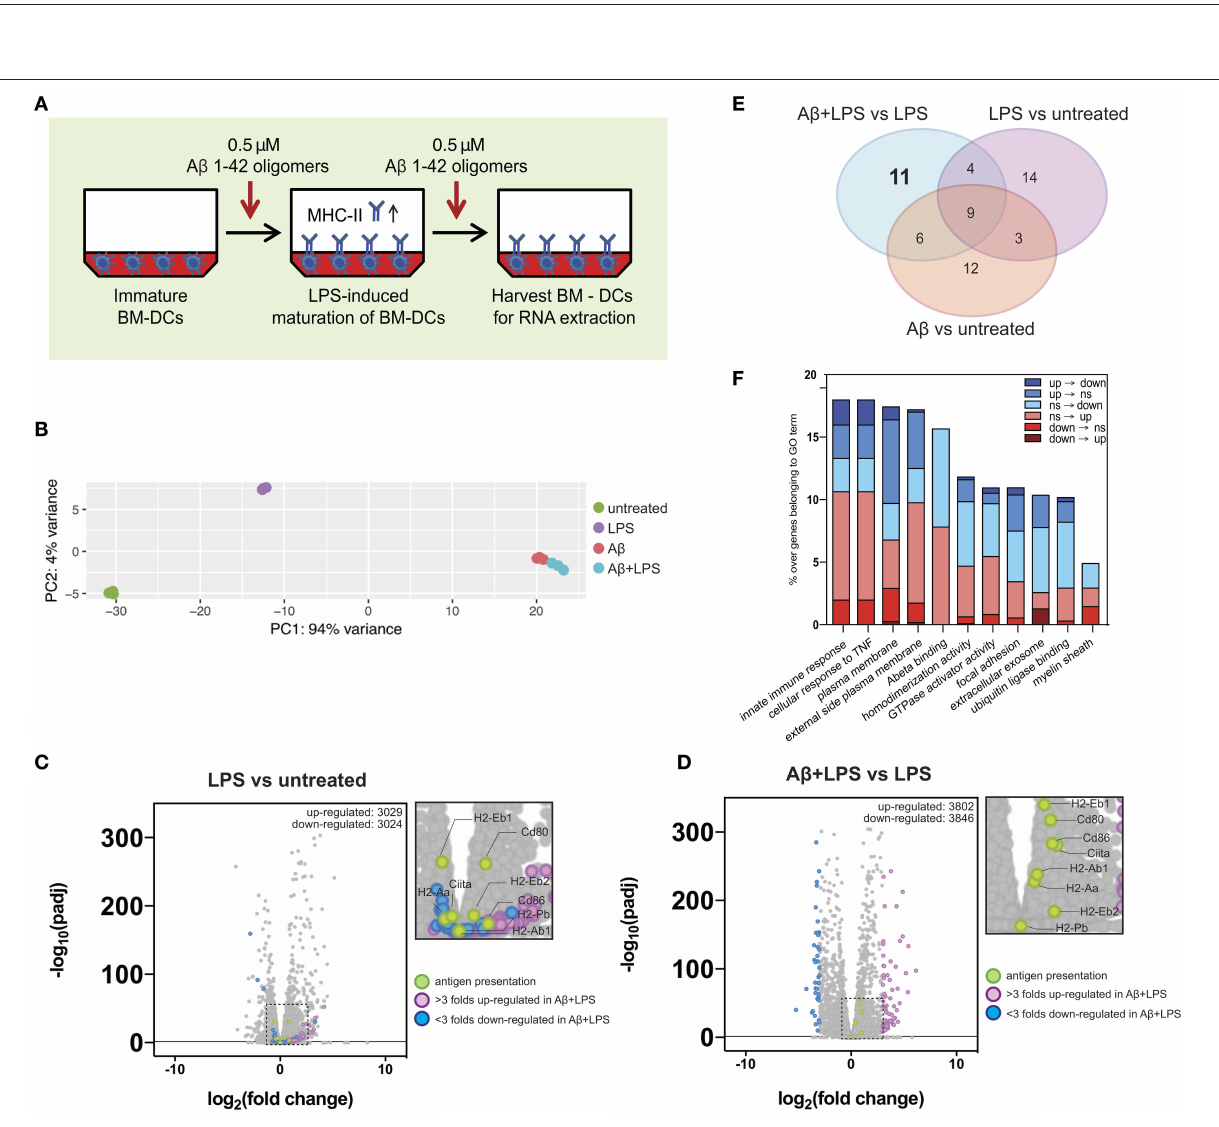
FIGURE 6 | Gene expression alterations of key immune factors in dendritic cells following A β 1-42 oligomer treatment. (A) Schematic of in vitro treatment of mouse BM-DCs with 0.5 µ M A β 1-42 oligomers for 4 days in total, starting 1 day before LPS-induced maturation (“A β + LPS” full setup). BM-DCs are harvested for RNA-extraction and -sequencing. (B) Principal component analysis (PCA) of RNAseq data. Four conditions are tested: untreated BM-DCs (“Untreated”; n = 3), LPS stimulation only (“LPS”; n = 3), A β stimulation only (“A β ”; n = 3) and A β stimulation combined with LPS treatment (“A β + LPS”; n = 3). (C,D) Volcano plots of RNAseq data for “LPS vs. Untreated” (C) and “A β + LPS vs. LPS” (D) comparisons. Key genes involved in antigen presentation are highlighted in green. Genes that are either more than 3 folds up-regulated (violet) or down-regulated (blue) in “A β + LPS vs. LPS” are highlighted. Significance is set at adjp < 0.05. (E) Venn diagram groups GO terms that are specifically enriched in each individual BM-DC treatment comparison. 11 GO-terms are exclusively altered by A β treatment of LPS-matured BM-DCs. (F) A β -induced gene expression changes within each of the 11 considered GO terms compared to LPS-maturation only (“A β + LPS vs. LPS” compared to “LPS vs. Untreated”). Bar graph depicts ratio of genes affected by the presence of A β over the total number of genes in the respective GO term. Gene expression switches are color-coded and defined as follows: (i) up-regulated (“up”; fold change > 1; adjp ≤ 0.05), (ii) down-regulated (“down”; fold change < − 1; adjp ≤ 0.05) and (iii) non-significant (“ns”; − 1 ≤ fold change ≤ 1; adjp >